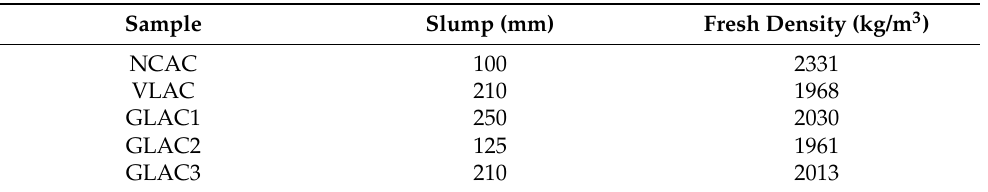
Figure 10. Slump measurement using the cone test method. Table 6. Fresh properties of green lightweight aggregate concrete (GLAC), local lightweight concrete (VLAC) and normal weight concrete (NCAC) at W/C of